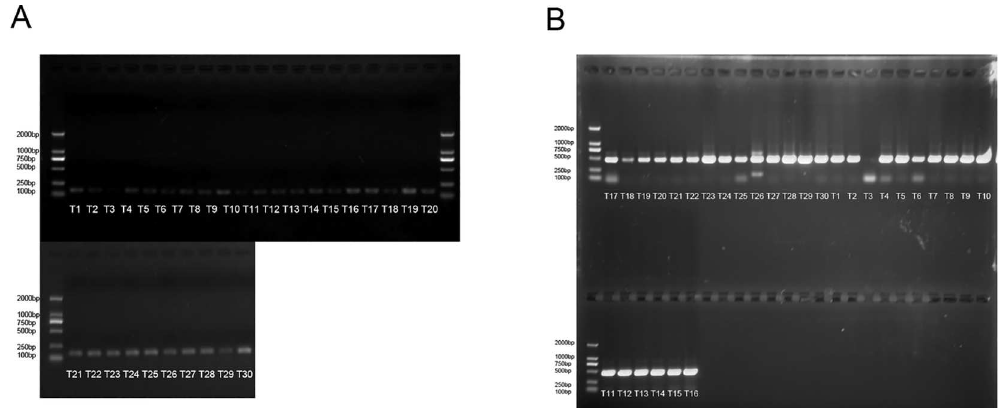
Fig 1. (A) Identification of cervical cancer tissues infected with HPV; (B) Identificationof HPV genotype. The target bands are located at 150 bp and 457 bp.